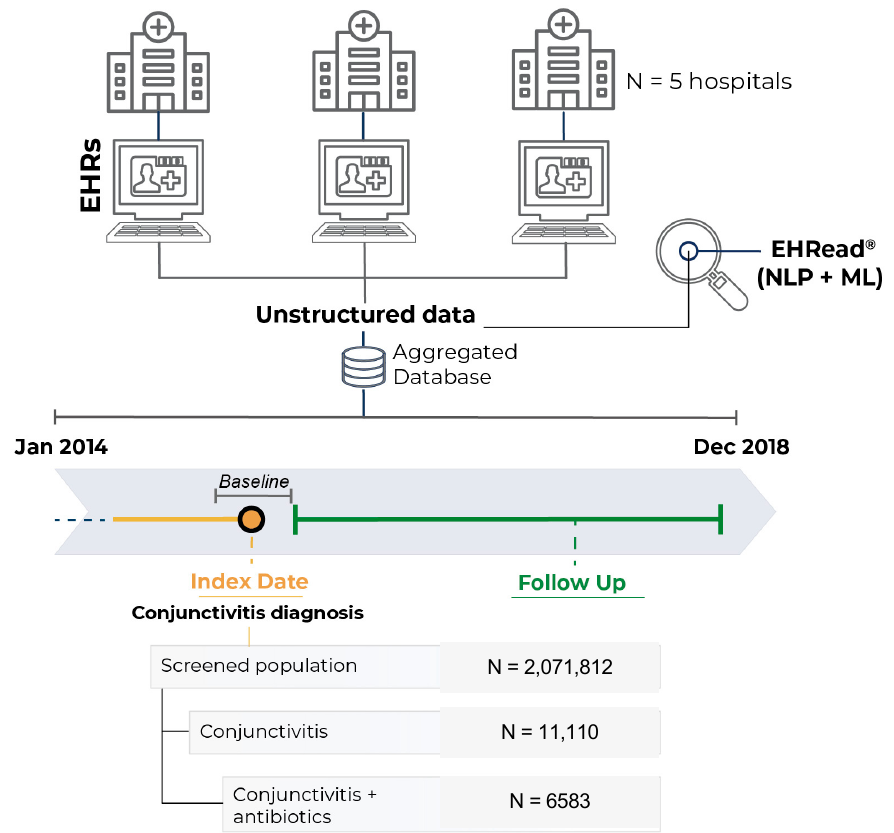
Figure 1. Study design and timeline. Unstructured data from patients’ EHRs was extracted and organized into an aggregated database with the EHRead ® technology. The Index Date was defined as the timepoint when diagnosis of conjunctivitis and antibiotic treatment were first identified within the EHRs of the patients. The follow-up period ranged from the Index Date to the end of the study period or the last data point available. Total number of patients with available EHRs, the number of patients with conjunctivitis, and the subset of patients with conjunctivitis treated with antibiotics in the participating hospitals from 1 January 2014 to 31 December 2018 are shown.